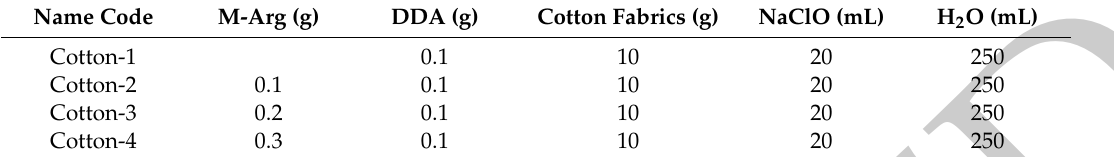
Table 1. The parameters for the preparation of antibacterial cotton fabric